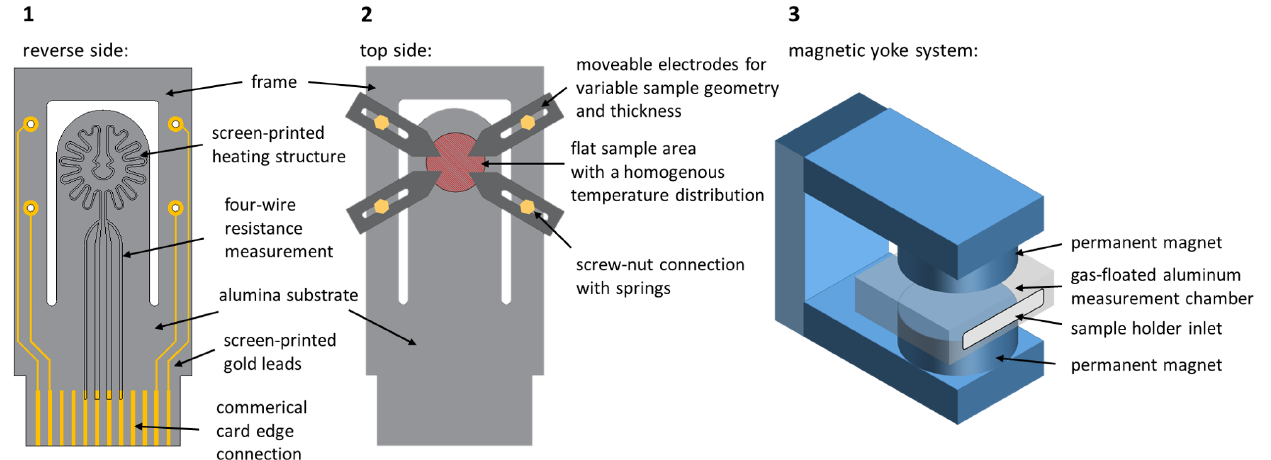
Figure 1. Schematic representation of the new measurement device. (1) Sample holder, with a thick film heating structure and card edge connection on the reverse side. (2) Top side, with a sample area having a maximum diameter of 12.7mm and four moveable electrodes for Hall and conductivity measurements, according to van der Pauw’s method. (3) Magnetic yoke system with permanent magnets and a gas-flushed aluminum measurement chamber.